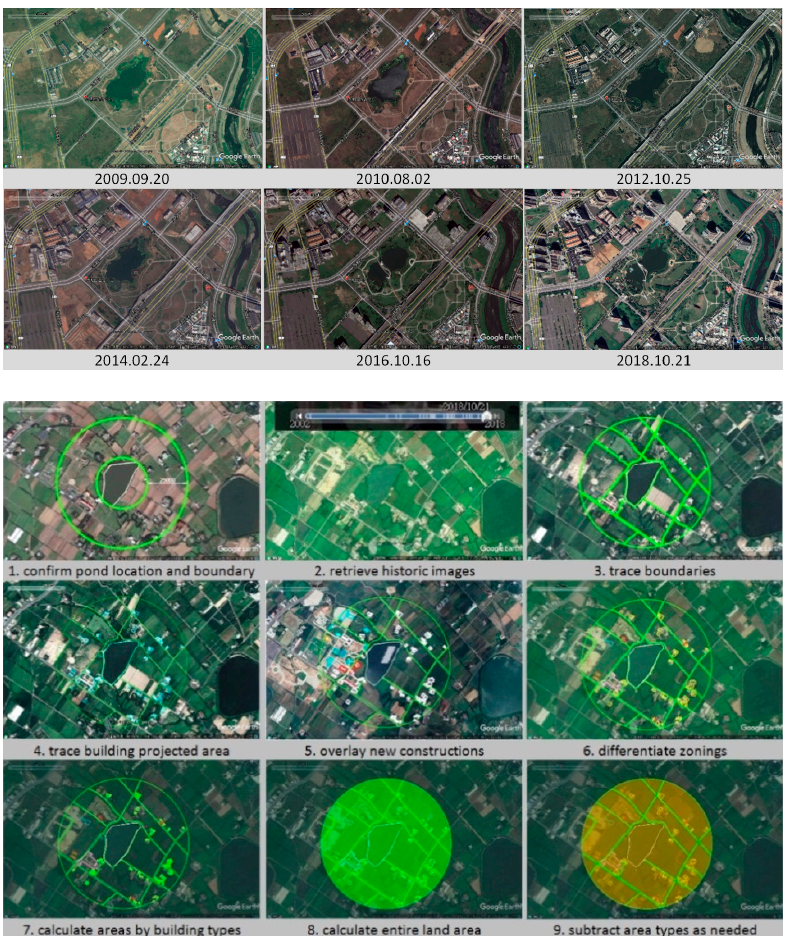
Figure 2. Flowchart.